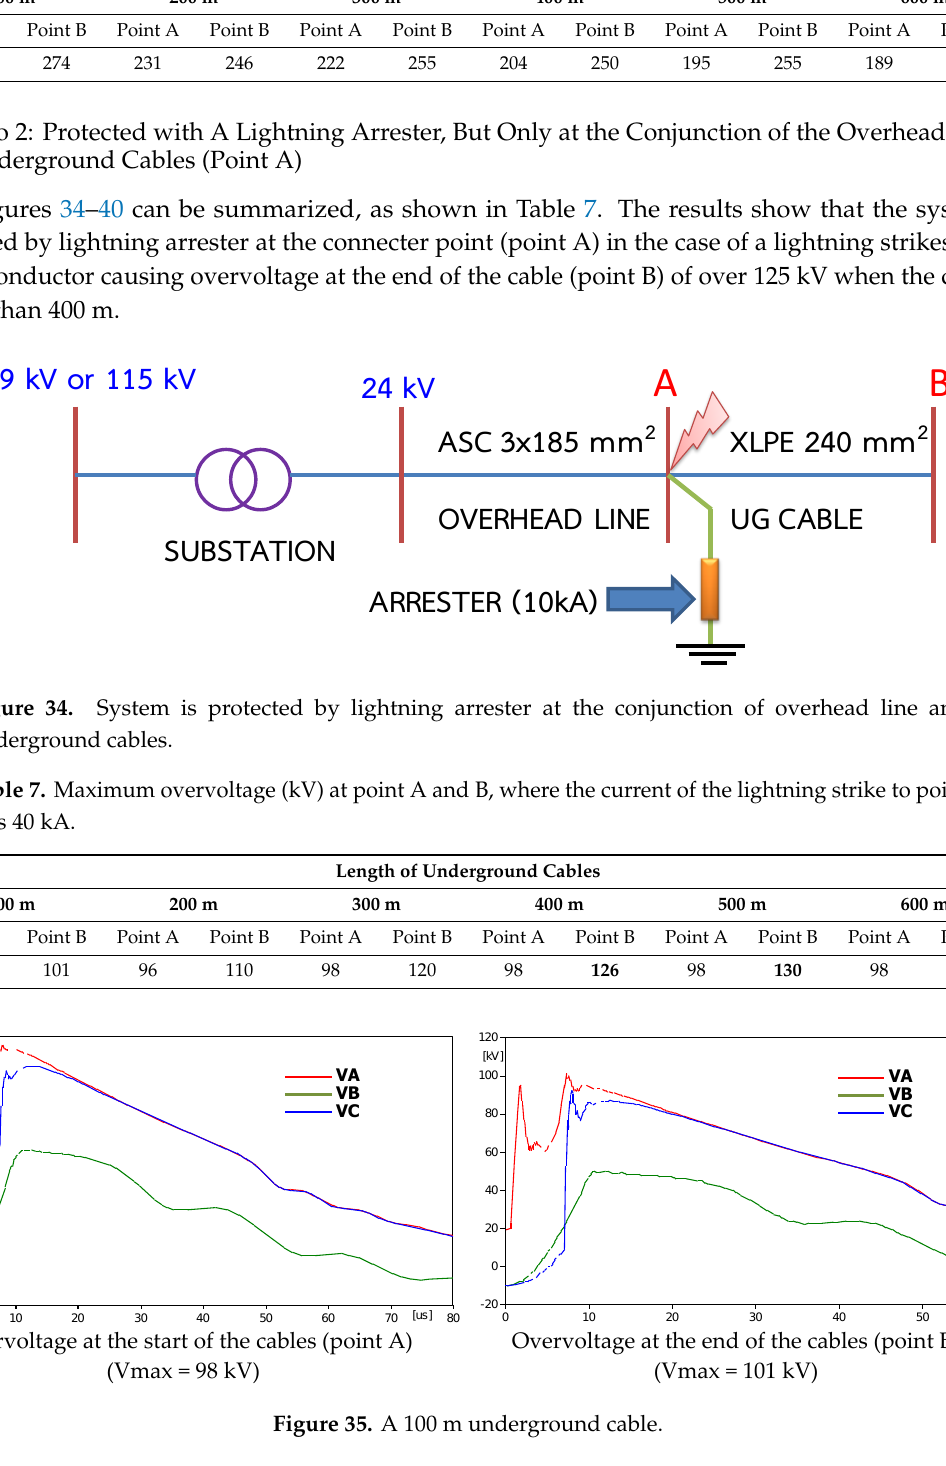
Figure 33. A 600 m underground cable.